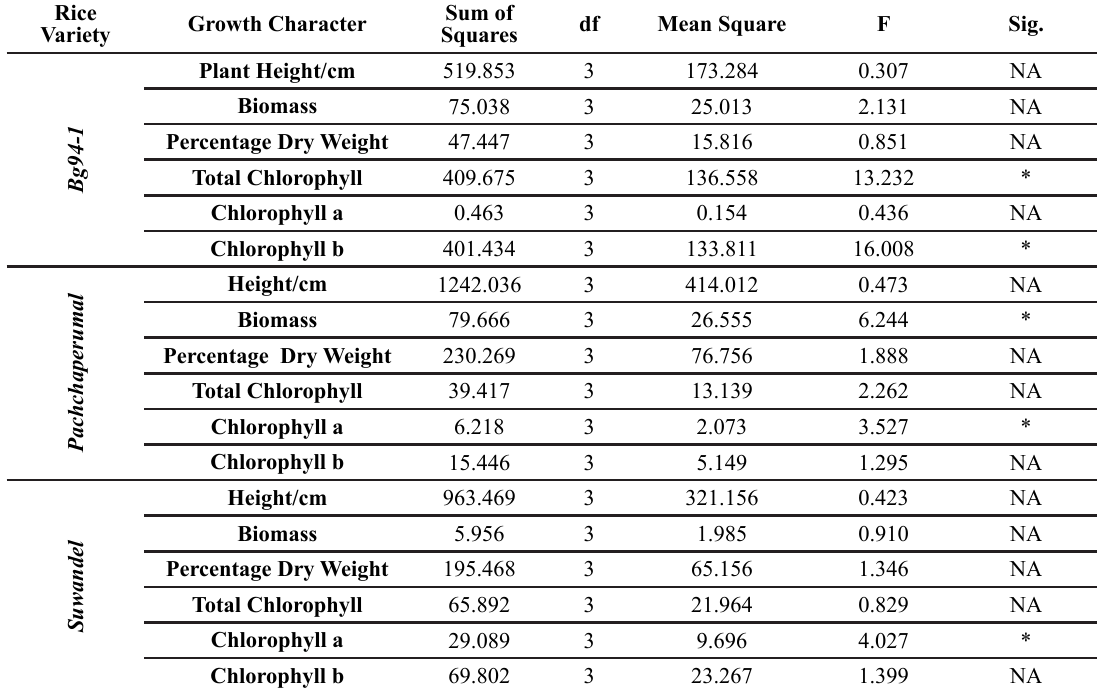
Table 4 : Summary of the one –way ANOVA perfumed on plant height, biomass, percentage dry weight, total chlorophyll, chlorophyll a and chlorophyll b for Bg94-1, Pachchaperumal and Suwandel rice varieties for nano-ZnO 60 mgL -1 and 120 mgL -1 . Rice Growth Variety